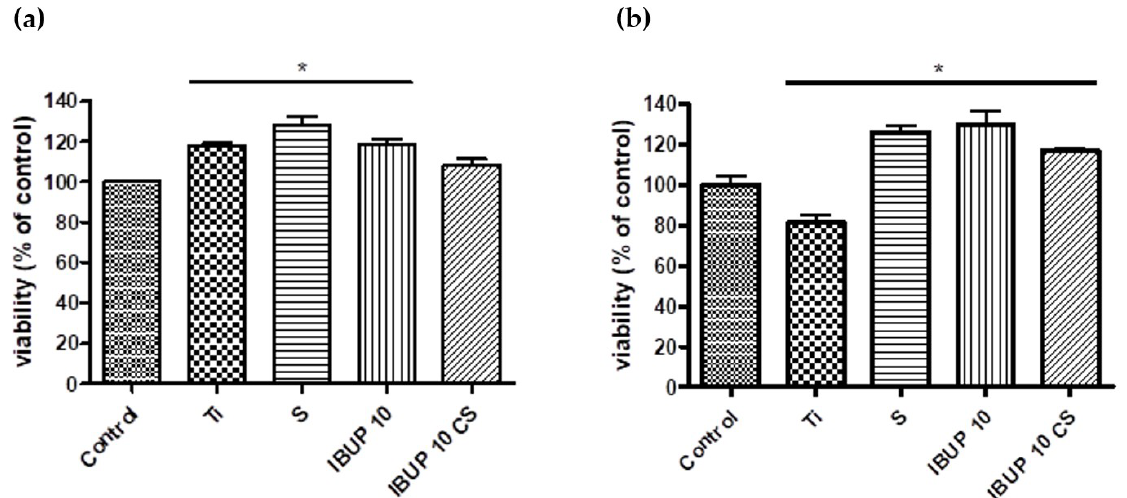
Figure 8. Viability of THP-1 cells attached to the surface of composite biopolymeric spheres coatings after ( a ) 24 h and ( b ) 72 h (data are presented as mean values ± SD and significance was determined at * p < 0.05).